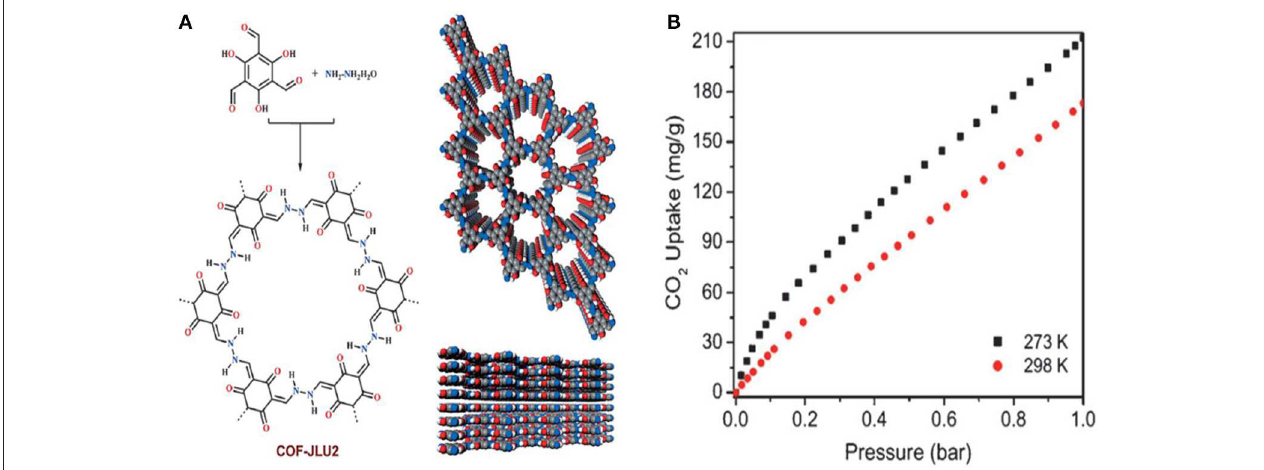
FIGURE 4 | (A) Structure of COF-JLU2 synthesized by Li et al. (2015) and (B) the CO 2 adsorption isotherms of COF-JLU2 measured at both 273 and 298K up to 1 bar pressure. Reprinted with permission © 2015 Wiley